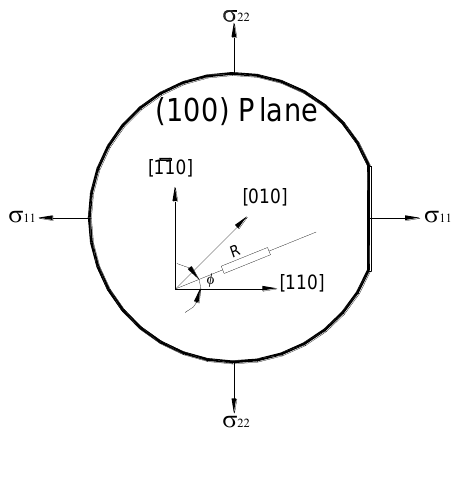
Figure 1. A piezoresistive element on (100) silicon substrate along general orientation (  ) with respect to [110] while subjected to biaxial state of